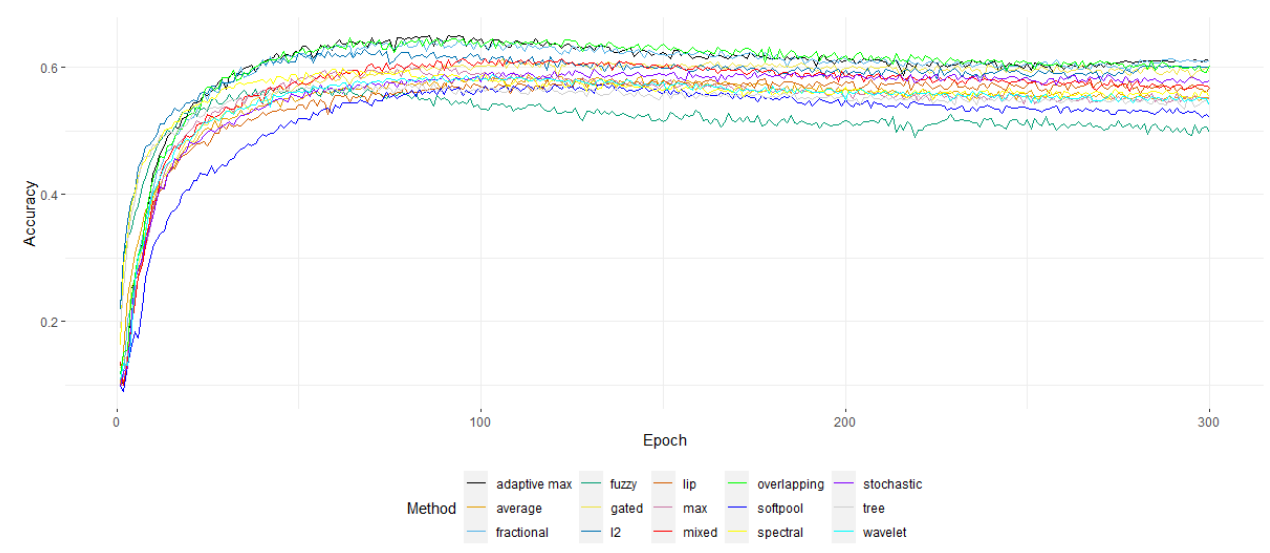
Figure 11. The top 1 accuracy of the models for the CIFAR10 dataset over the epochs.